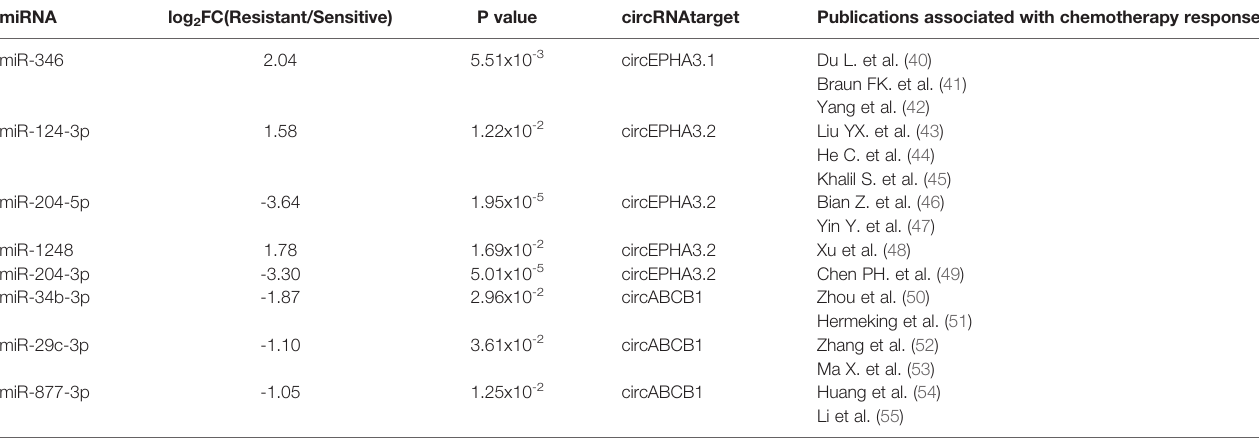
TABLE 1 | Differential expression of the 8 miRNAs that were associated with response to chemotherapy and predicted to bind to the three circRNAs by at least two software